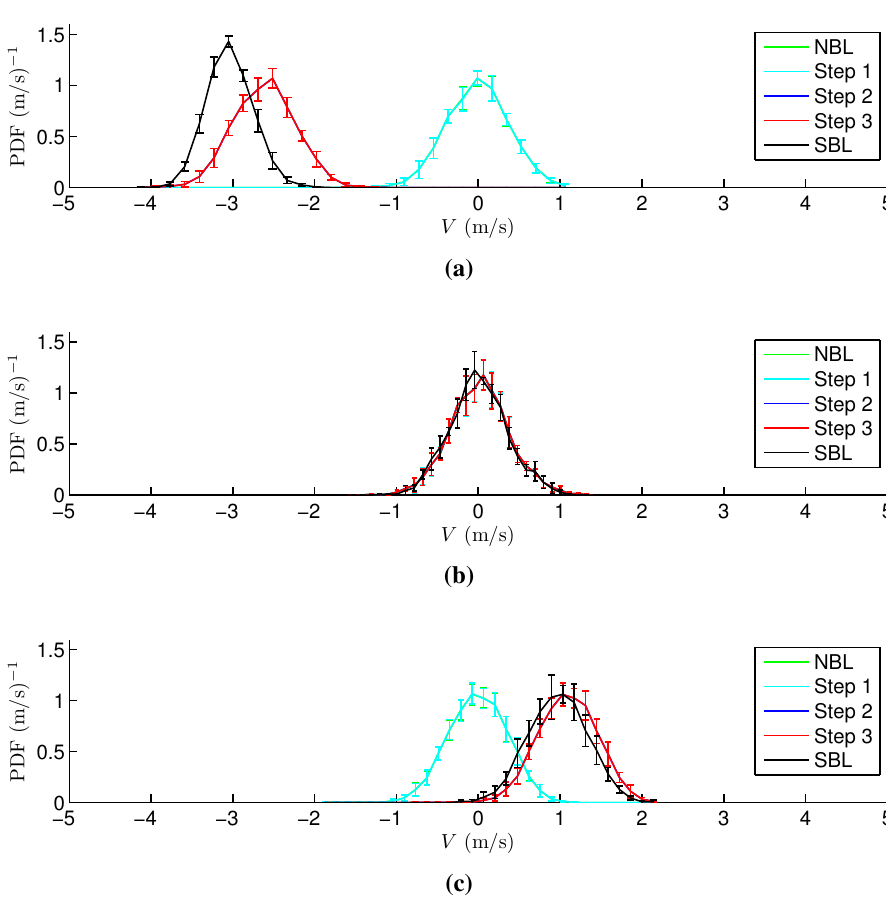
Figure 19. Probability density functions for the lateral wind velocity, V , for a single case (control). ( a ) Rotor top; ( b ) Rotor hub; ( c ) Rotor bottom. Figure 20 compares PDFs for the wind direction time series at the same three locations as before. Step 1 does not significantly alter the PDF for θ ; it slightly widens the PDF at the rotor bottom due to adjustments to the mean longitudinal wind speed there. Step 2 significantly modifies the PDF for θ so that it closely resembles that for the SBL wind field. The small differences between the PDFs from the NBL-modified (Step 3) wind field and the SBL wind field are due to the approximated linear variation assumed for the mean wind direction profile. Step 3 has little effect on the PDF for θ because although the longitudinal turbulence is scaled, it is relatively very small compared to U to influence the time-varying wind direction to any great